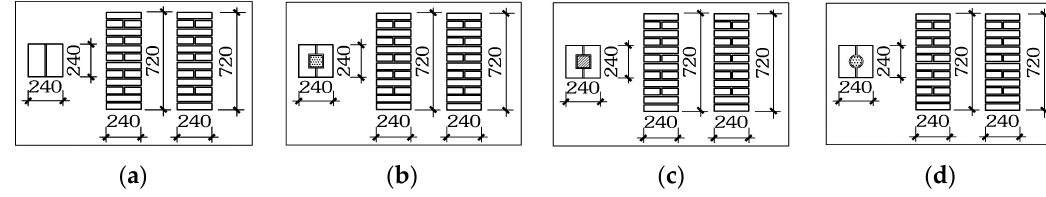
Figure 1. Dimensions and structural details for specimens with 240 mm × 240 mm cross section: ( a ) standard specimen; ( b ) square ‐ shaped wood embedded; ( c ) square ‐ shaped steel pipe embedded; and ( d ) circular steel pipe embedded.